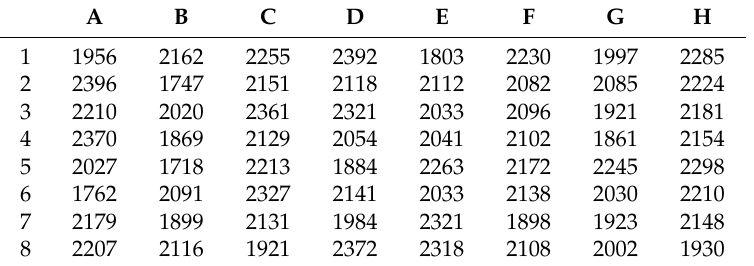
Table A5. Measured values of CO 2 concentration distribution in Experiment A2